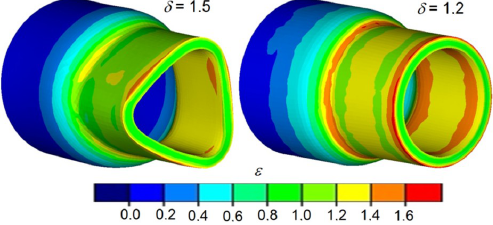
Figure 11. Shape of the forging obtained from thin-walled semi-finished products with small relative wall thickness t o /D = 0.095 and relative speed v/n = 2 mm/rotation.